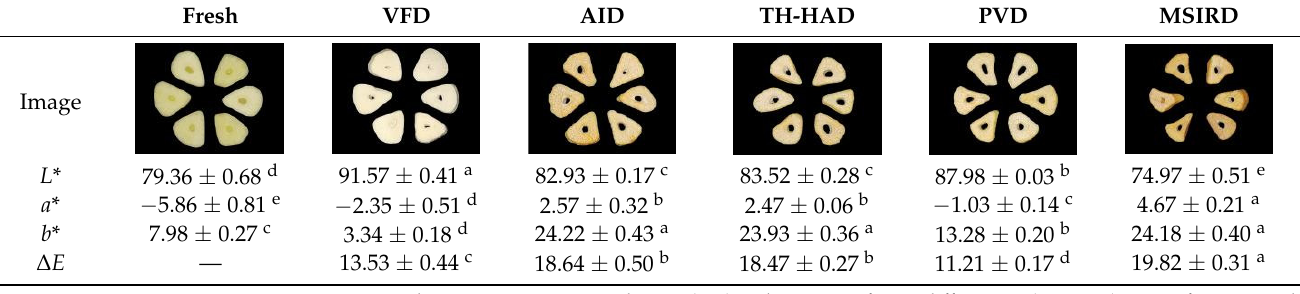
Figure 7. The microstructure of garlic slices dried in different methods at 100 and 200 magnifica- tions. Table 2. Images and color parameters of garlic slices under various drying methods. Fresh VFD AID TH-HAD PVD MSIRD VFD AID Image